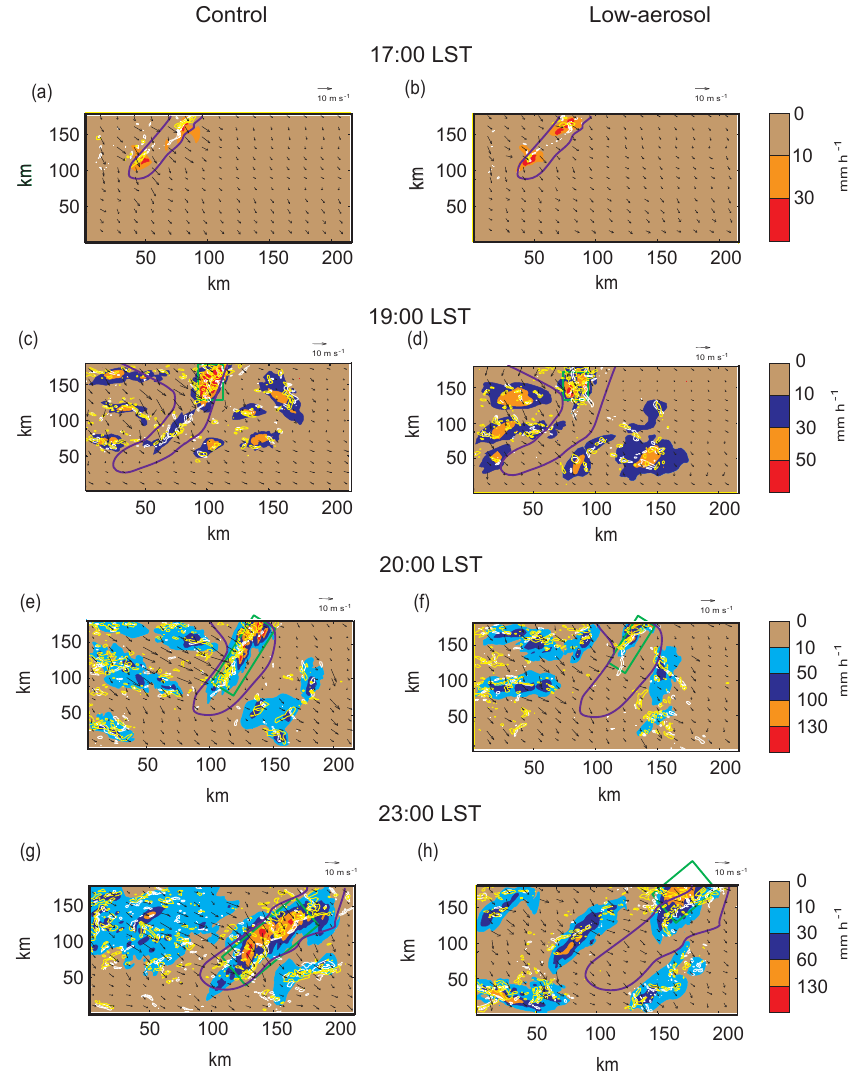
Figure 11. Same as in Fig. 10 but with wind vector fields (arrows), which are superimposed on the precipitation, convergence, and conden- sation